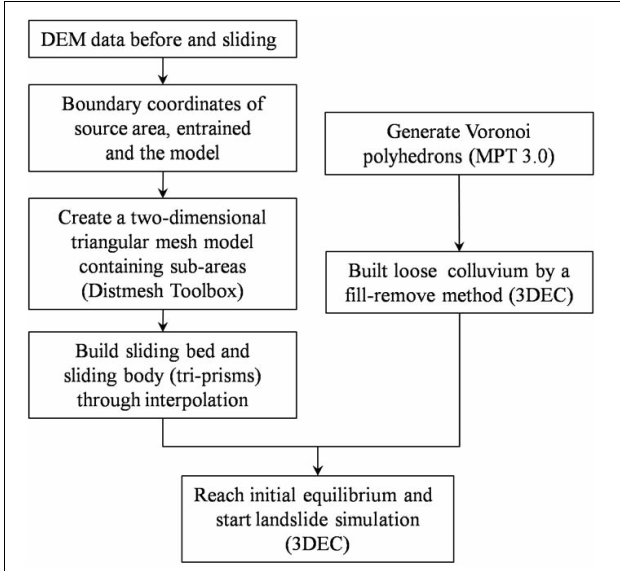
FIGURE 6 | Flowchart of numerical modeling for mass movement of landslides.